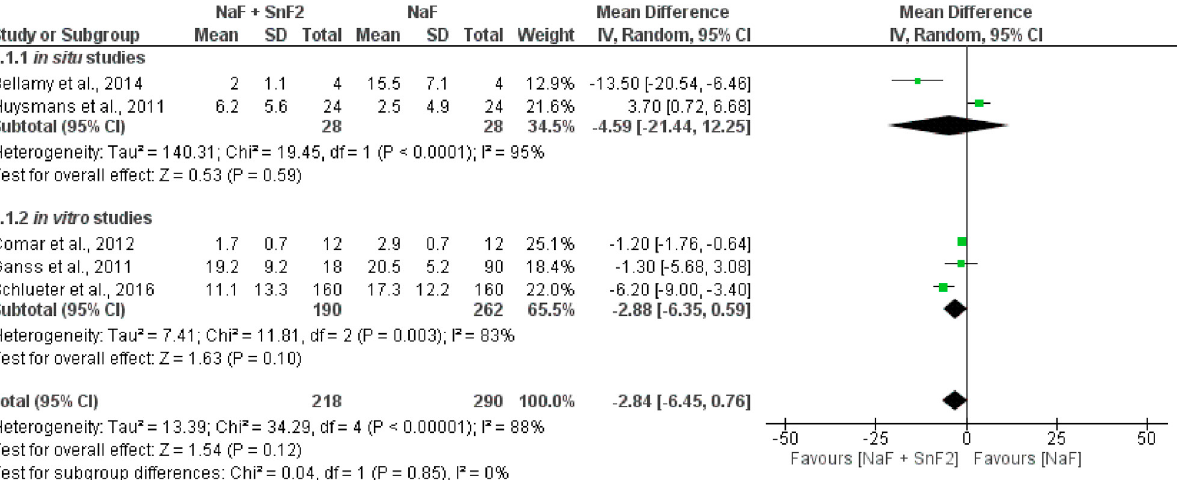
Figure 3. Summary findings of the meta-analyses comparing the use of SnF